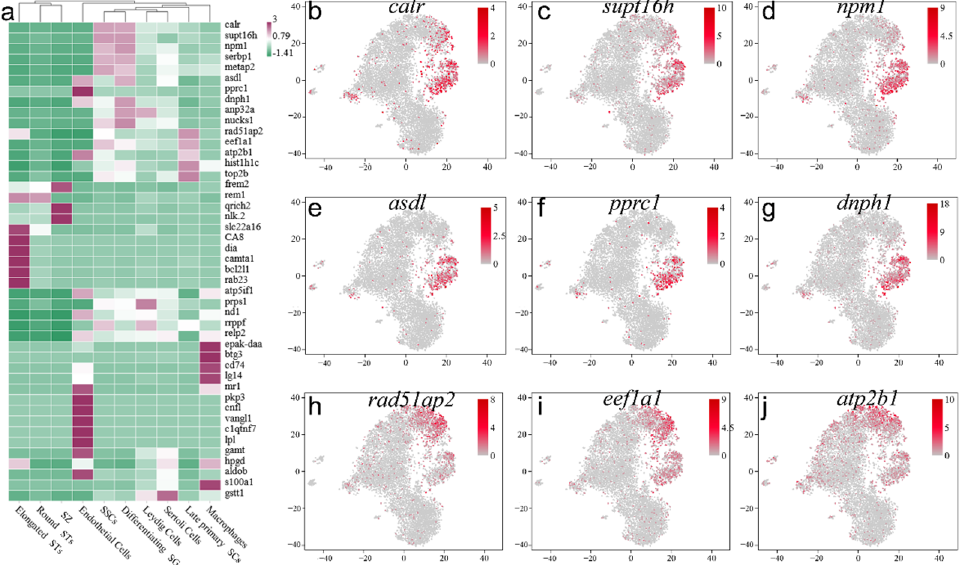
Figure 4. Selection of germ cell marker genes. ( a ) The heatmap of the most DEGs in 10 cell types. ( b – j ) The selected genes located in all clusters visualized by t-SNE. ( b ) calr , ( c ) supt16h , ( d ) npm1 , ( e ) asdl , ( f ) pprc1 , ( g ) dnph1 , ( h ) rad51ap2 , ( i ) eef1a1 , ( j ) atp2b1 . DEGs, differential expressed genes. SSC, spermatogonia stem cell; SG, spermatogonium; SC, spermatocyte; ST, spermatid; SZ, spermatozoon.